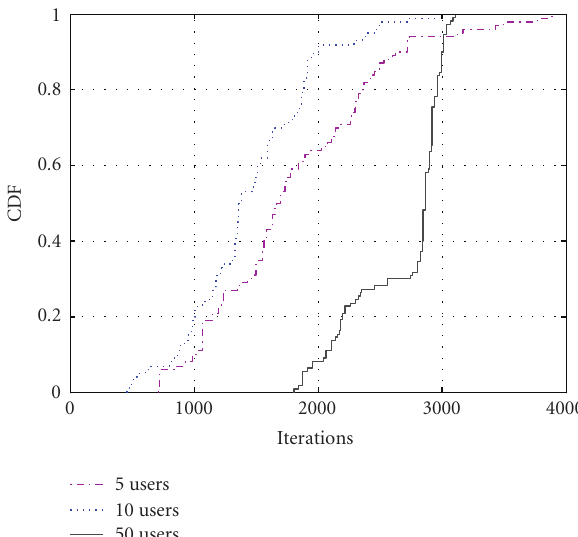
Figure 14: CDF of number of iterations with greedy algorithm.